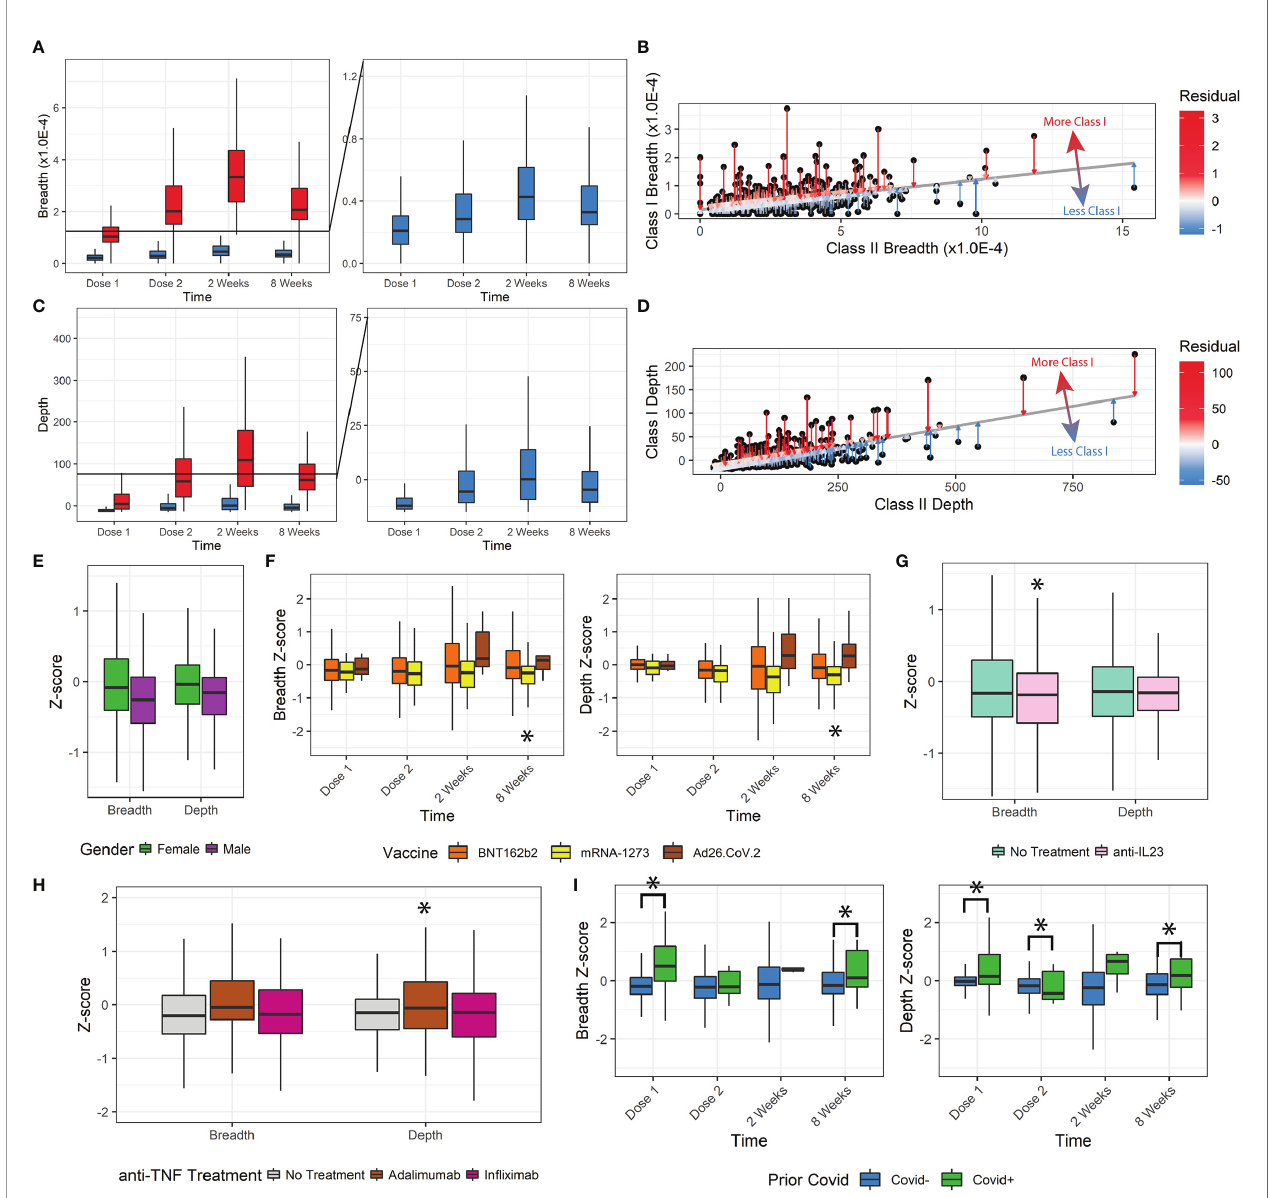
FIGURE 2 | Class-I and Class-II TCR metrics. (A, B) Class-I-speci fi c breadth was consistently lower than Class-II-speci fi c breadth. The residual metric was used to describe how much Class-I-speci fi c breadth was observed relative to expected. (C, D) The Class-I/II residual was replicated for depth. (E) Z-scores for female patients were higher. (F) Z-scores for mRNA-1273 patients were signi fi cantly lower. Ad26.COV2.S differences were not statistically signi fi cant with the small sample size, but trended higher. (G, H) Anti-TNF treatment by adalimumab but not in fl iximab increased depth z-scores, and anti-IL23 decreased breadth z-scores. (I) Prior covid infection was signi fi cantly associated with higher z-scores